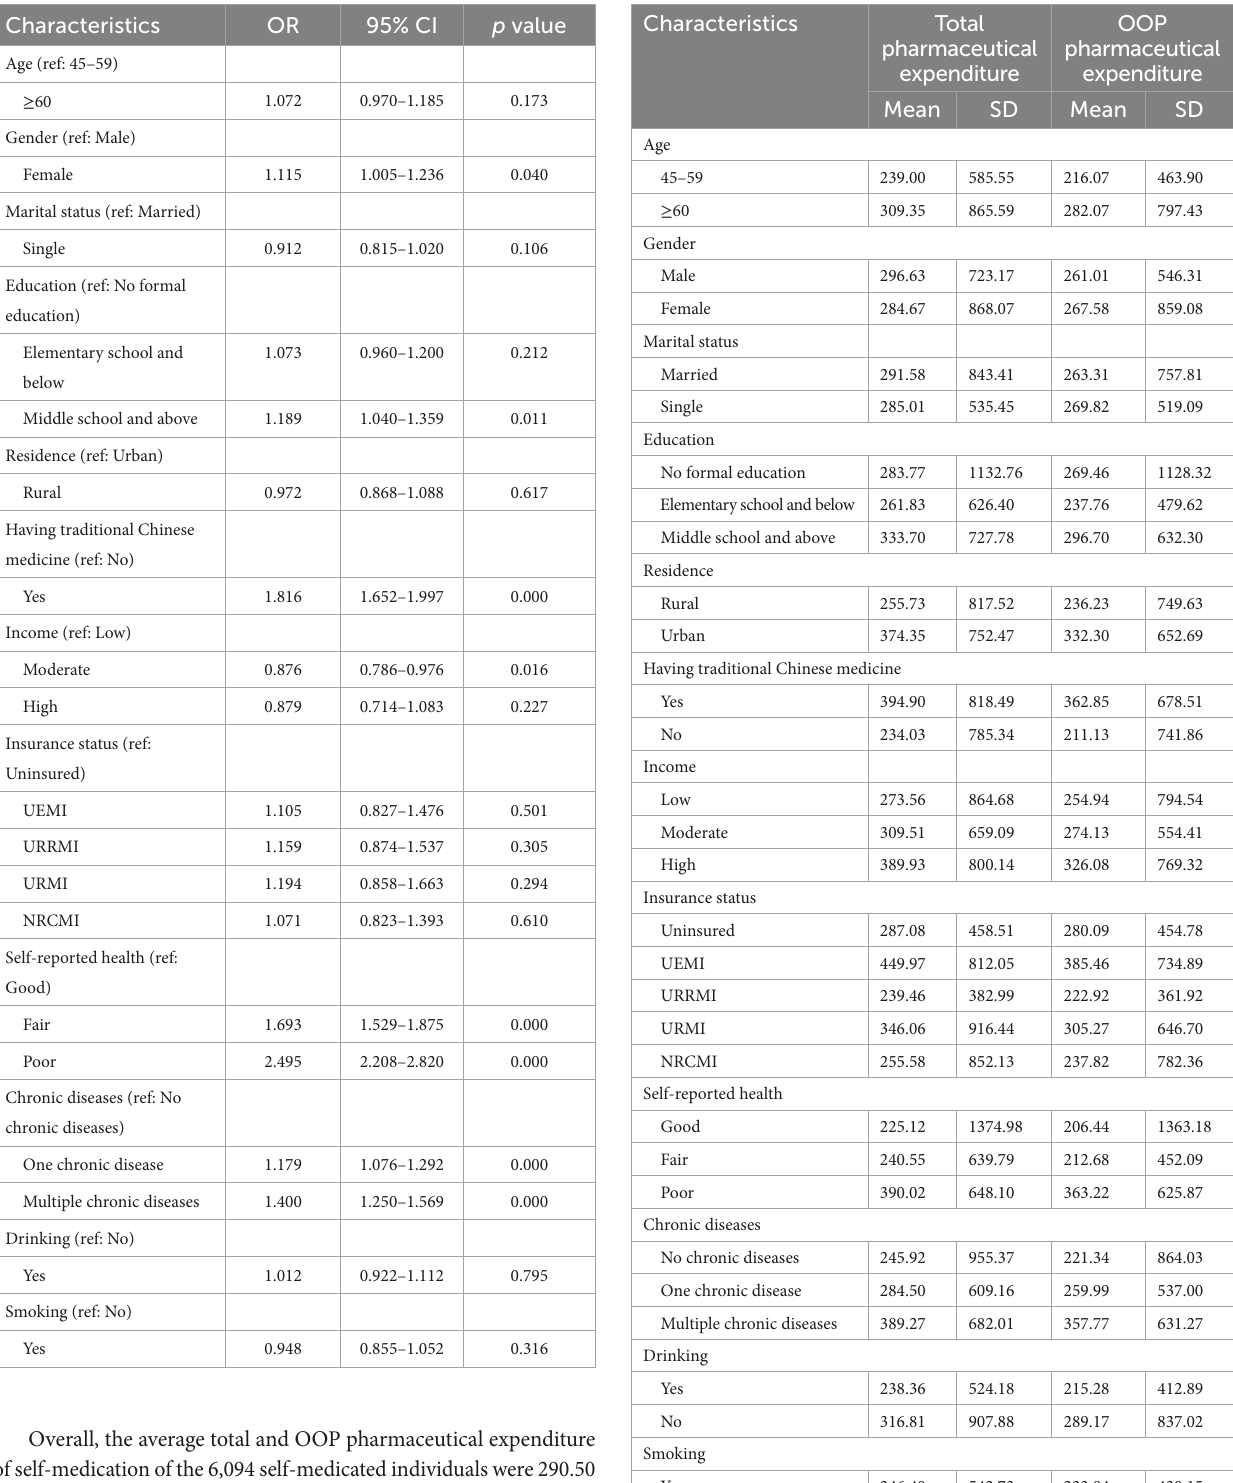
TABLE 2 Binary logistic regression on self-medication incidence ( n = 10,841).